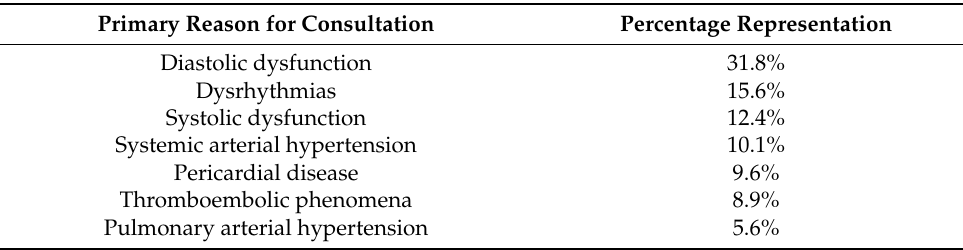
Table 2. Most frequent reasons to consult the cardiology team at St. Jude Children’s Research Hospital between